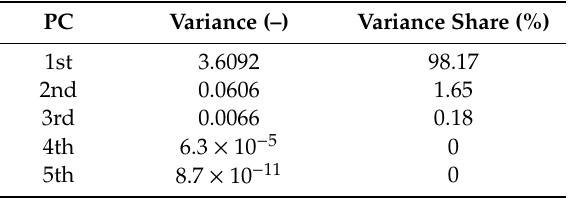
Table 2. Classification e ffi ciency test results for variable data block lengths.